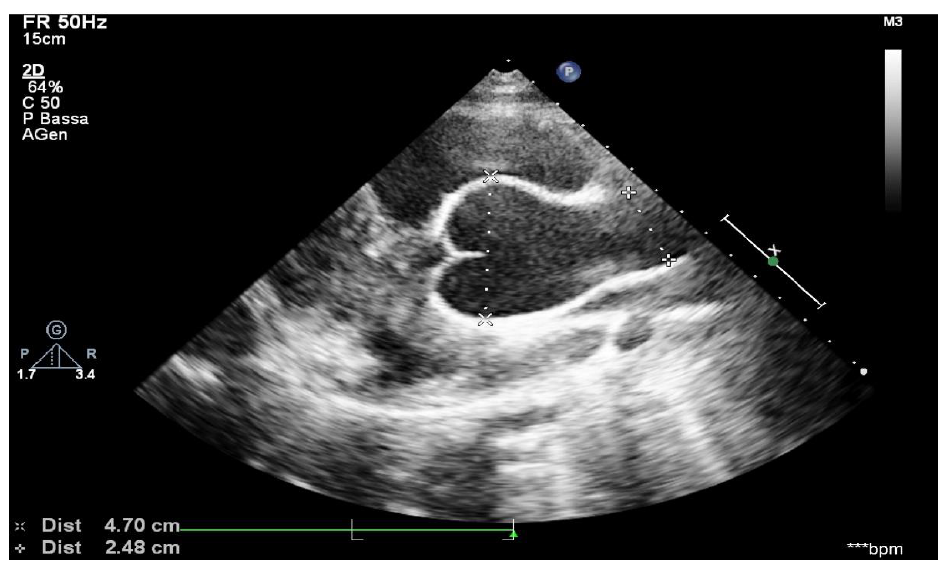
Figure 1. Aortic arch from suprasternal view.